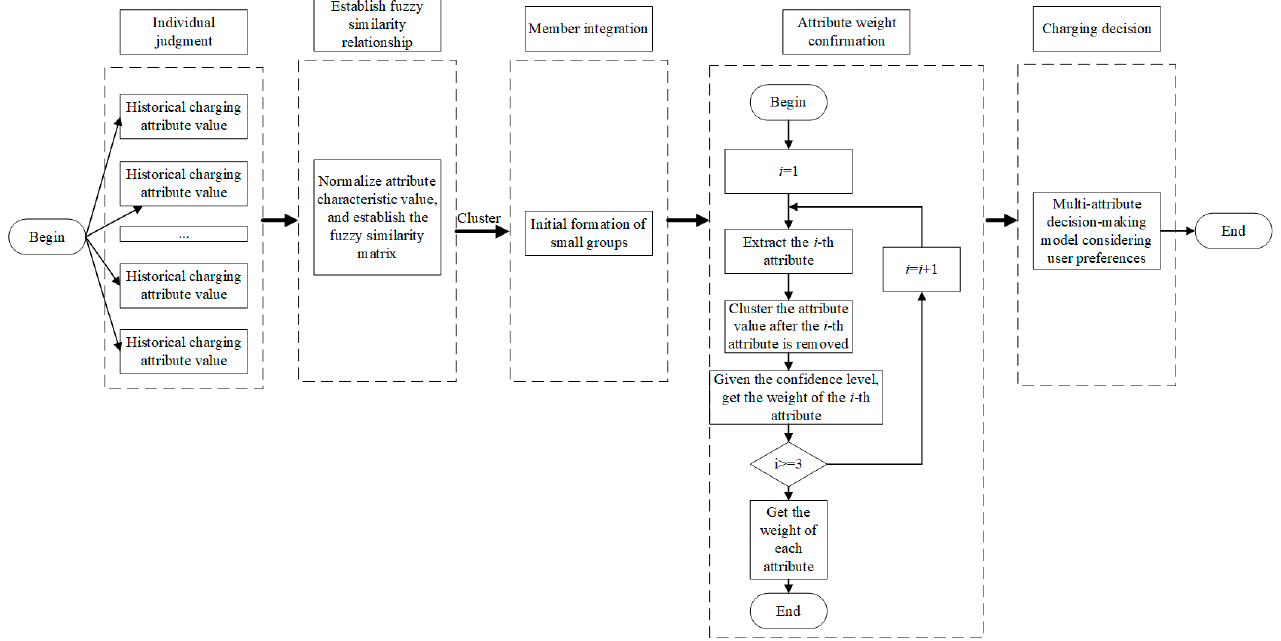
Figure 5. Decision-making process with behavior